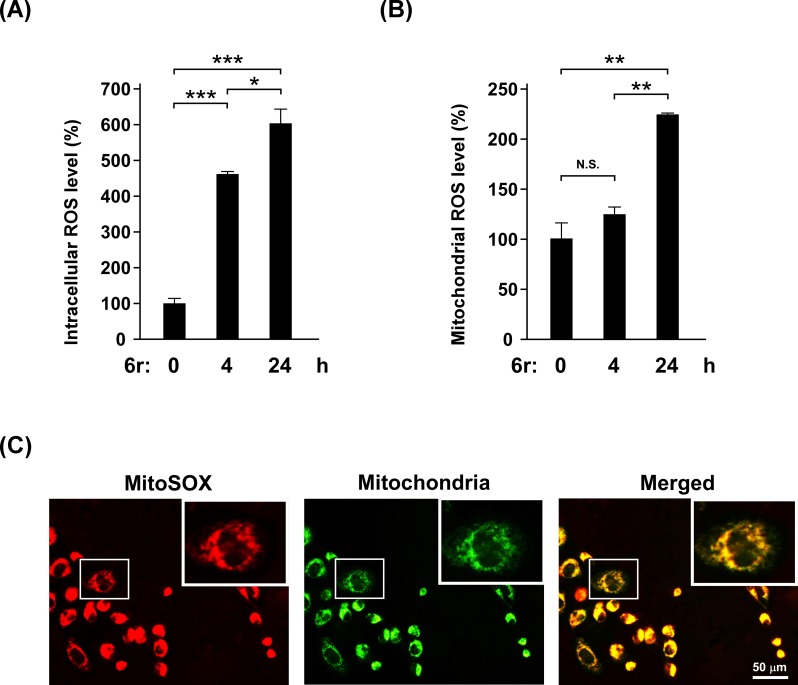
Prolonged inhibition of CTSS by 6r causes a second oxidative burst from the mitochondria.(A) Cells were incubated with 20 μM of 6r for the indicated times, and intracellular ROS levels were detected using DCFH-DA, and were quantified through flow cytometry. The data represent the mean ± SD of 3 independent experiments. (B) After treatment with 20 μM of 6r for the indicated times, elevated mitochondria-generated ROS were identified using MitoSOX, and were quantified using flow cytometry. The data represent the mean ± SD of 3 independent experiments. Differences were found to be statistically significant at *P < 0.05, **P < 0.01, and ***P < 0.001. N.S. denotes no significant difference. (C) Cells were treated with 20 μM of 6r for 24 h, and then labelled with CytoPainter MitoGreen and MitoSOX red. Yellow color in the merged figure denotes mitochondria that are actively producing ROS.